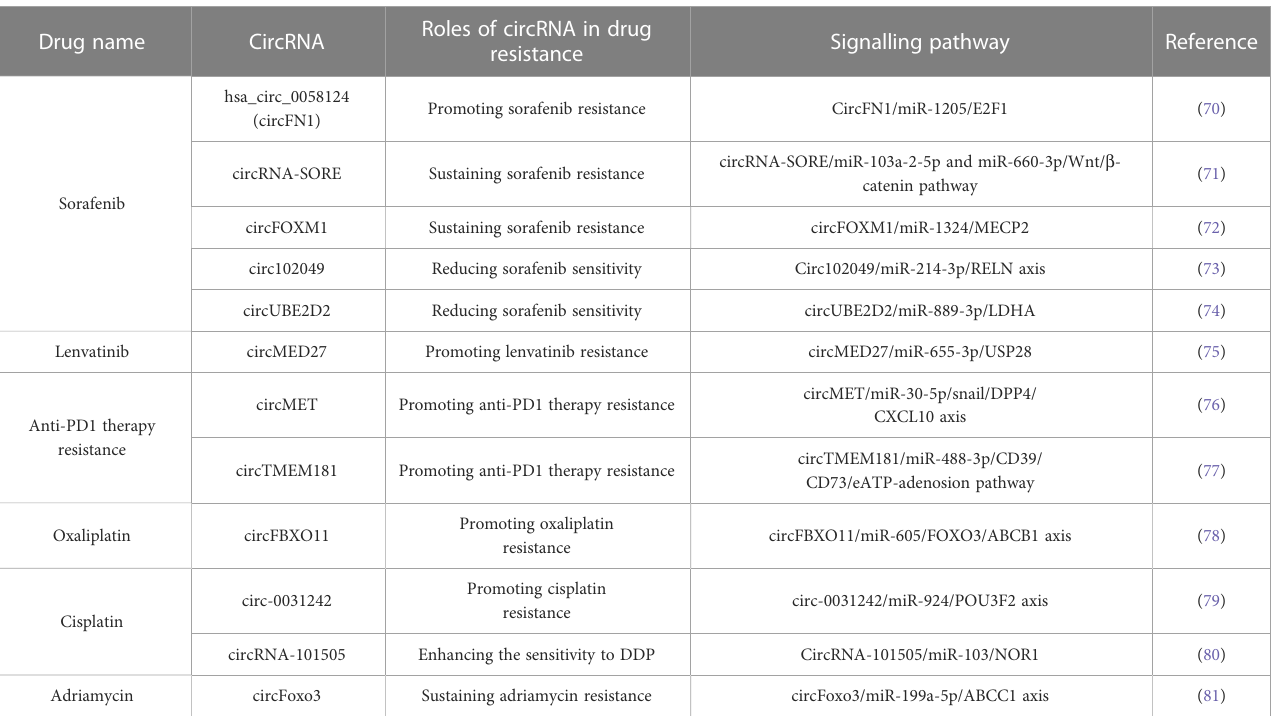
TABLE 1 Summary of circRNAs in drug resistance in HCC.